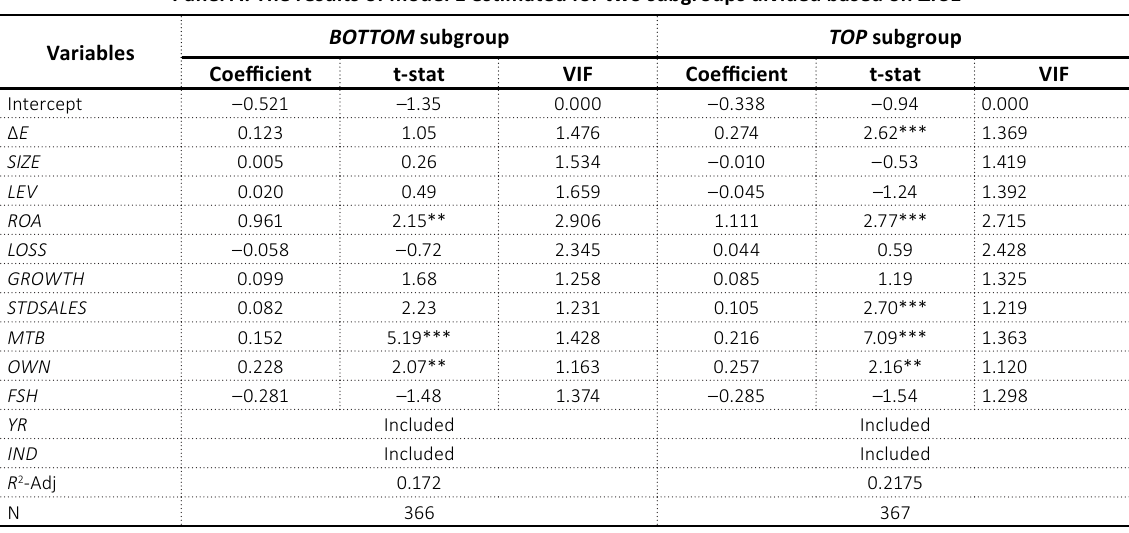
Panel B. The results of model 1 estimated for two subgroups divided based on ∆ IC